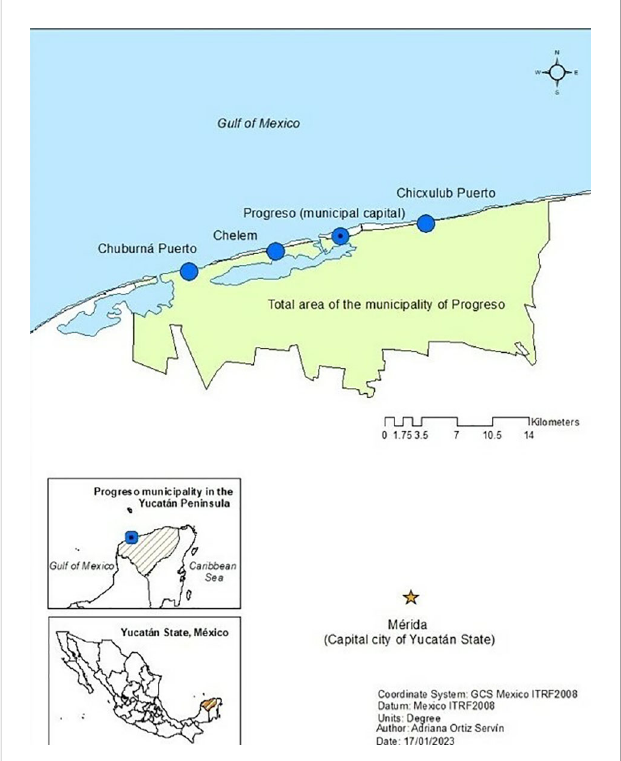
FIGURE 1 Study area. The municipality of Progreso and localities studied, in the central portion of the Yucatan coast,